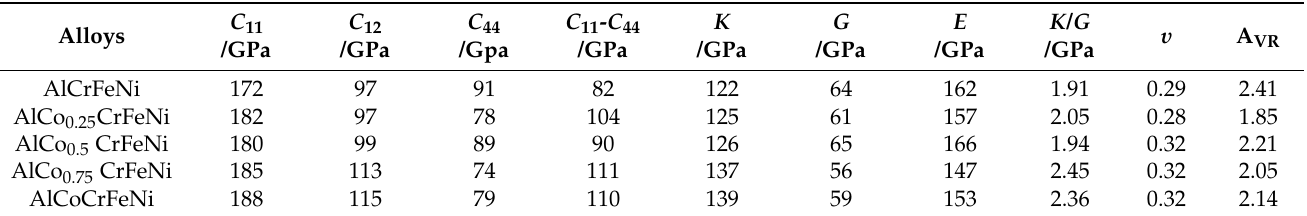
Table 4. Calculated elastic constant, elastic modulus, υ and A VR of AlCo x CrFeNi (x = 0, 0.25, 0.5, 0.75, 1)